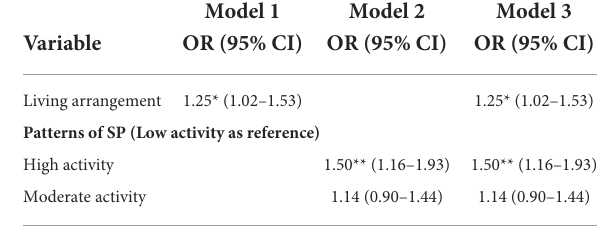
TABLE 5 Logistic regression models between living arrangement, patterns of social participation and negative emotions ( n =